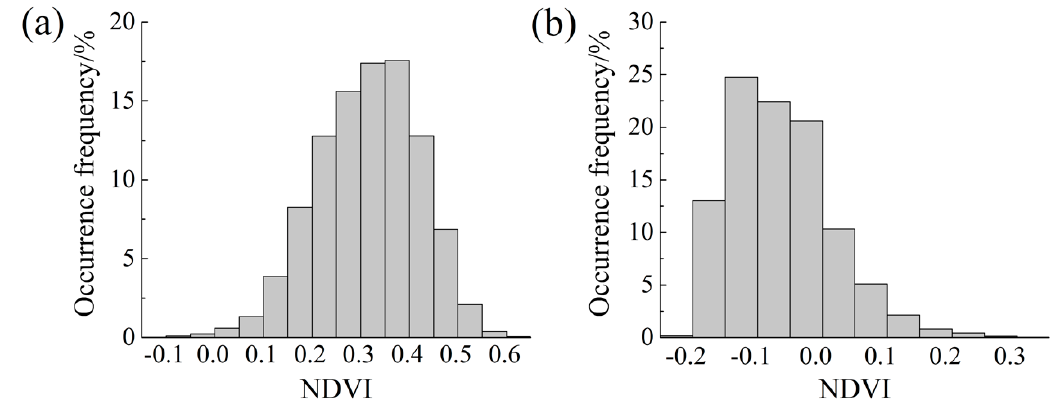
Figure 5. NDVI occurrence frequency histogram of ( a ) R. aureum and ( b ) volcanic ash.